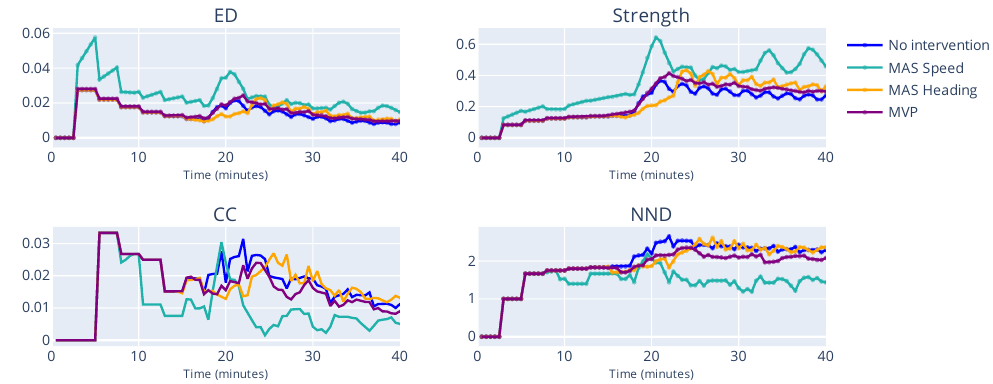
Figure 14. Miles-in-Trail with 16 aircraft per